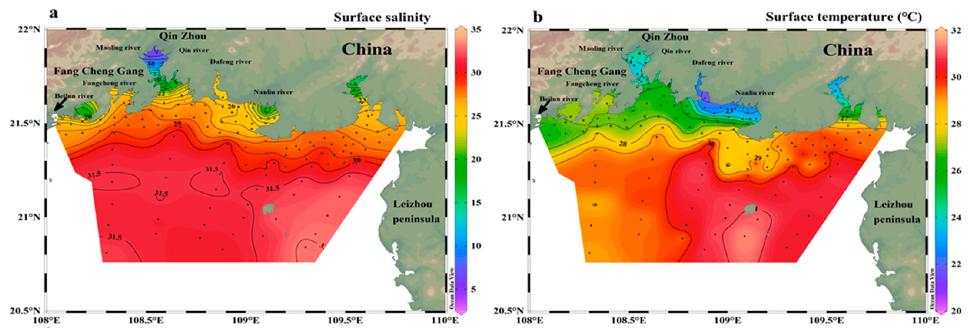
Figure 2. Surface distributions of salinity ( a ) and temperature ( b ) during our investigation period in May 2021. Table 1. Mean sea level at Beihai, Qinzhou, and Fangchenggang stations (unit: cm, reference datum: 85).